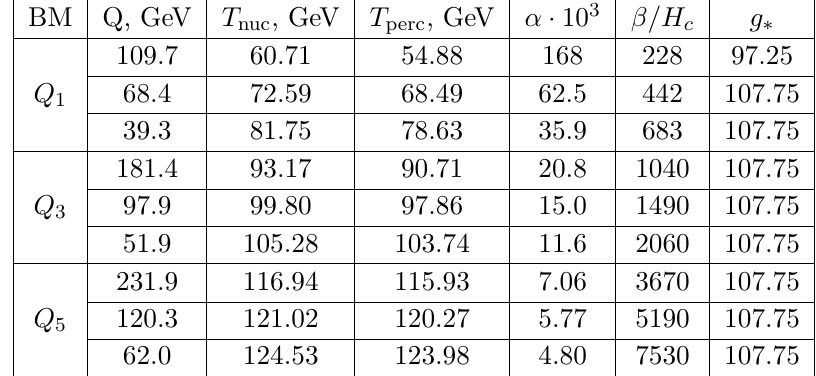
Table 2 . The renormalization scale Q , nucleation and percolation temperatures, parameters α and β/H c for BM Q 1 , Q 3 , Q 5 . For each point we calculate the first order electroweak phase transition parameters taking the renormalization scale 2 T perc , T perc and T perc / 2